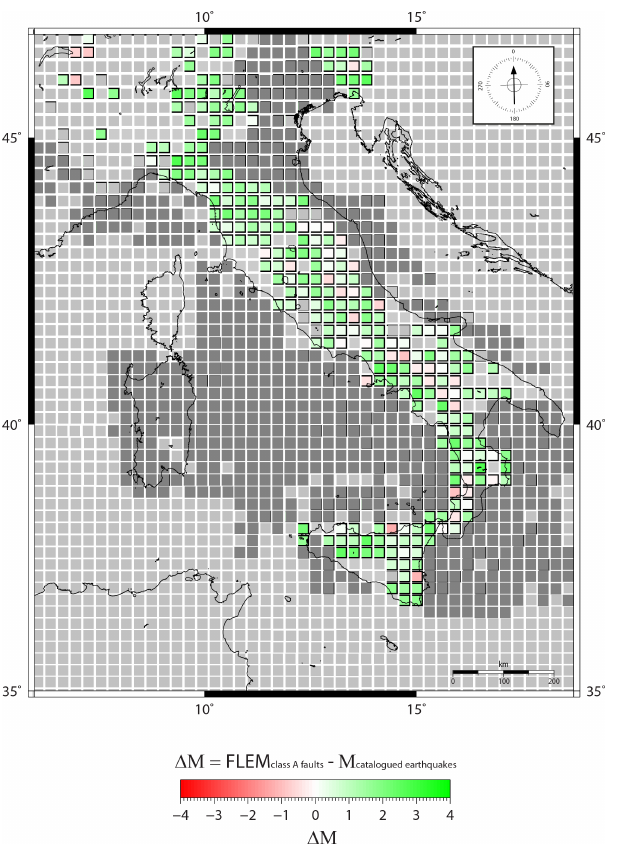
Figure 11. Map of the difference between FLEM values (only from class B faults; Fig. 8) and maximum magnitudes from historic or instrumental earthquakes (Fig. 9). Light grey is for cells with no data, whereas light purple is for cells where the longest faults belong to the class A set. See Fig. 12 for the interpretation of red vs. green